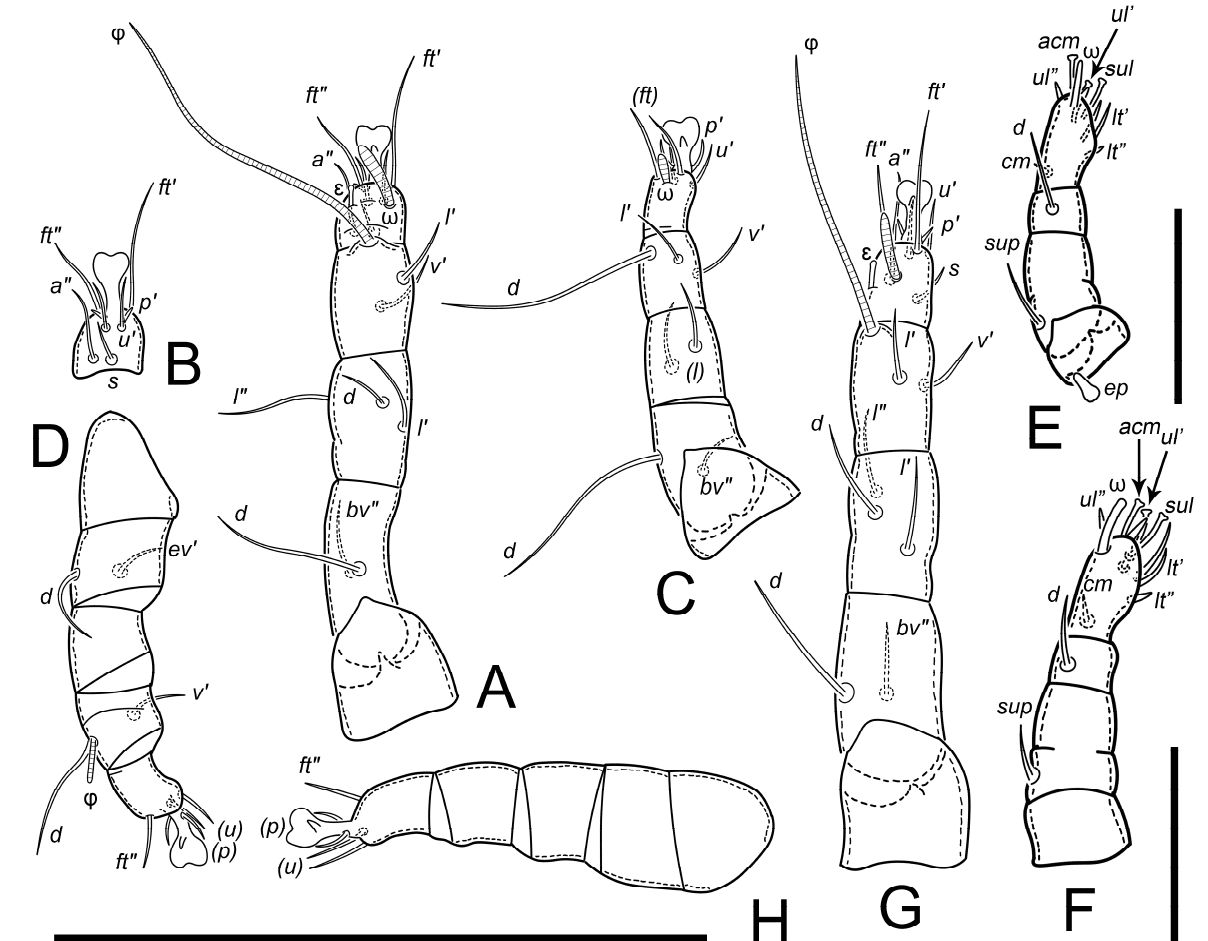
Figure 11. Paralycus daeira sp. n., larva ( A – E ) and protonymph ( F – H ): ( A )—leg I, left, dorsal view; ( B )—tarsus I, left, ventral view; ( C )—leg II, left, dorsal view; ( D )—leg III, left, paraxial view; ( E )—palp, left, dorsal view; ( F )—palp, left, dorsal view; ( G )—leg I, left, dorsal view; ( H )—leg IV, left, paraxial view. Scale bar 50 µm ( A – D , G , H ), 10 µm ( E , F ). Paralycus persephone sp.